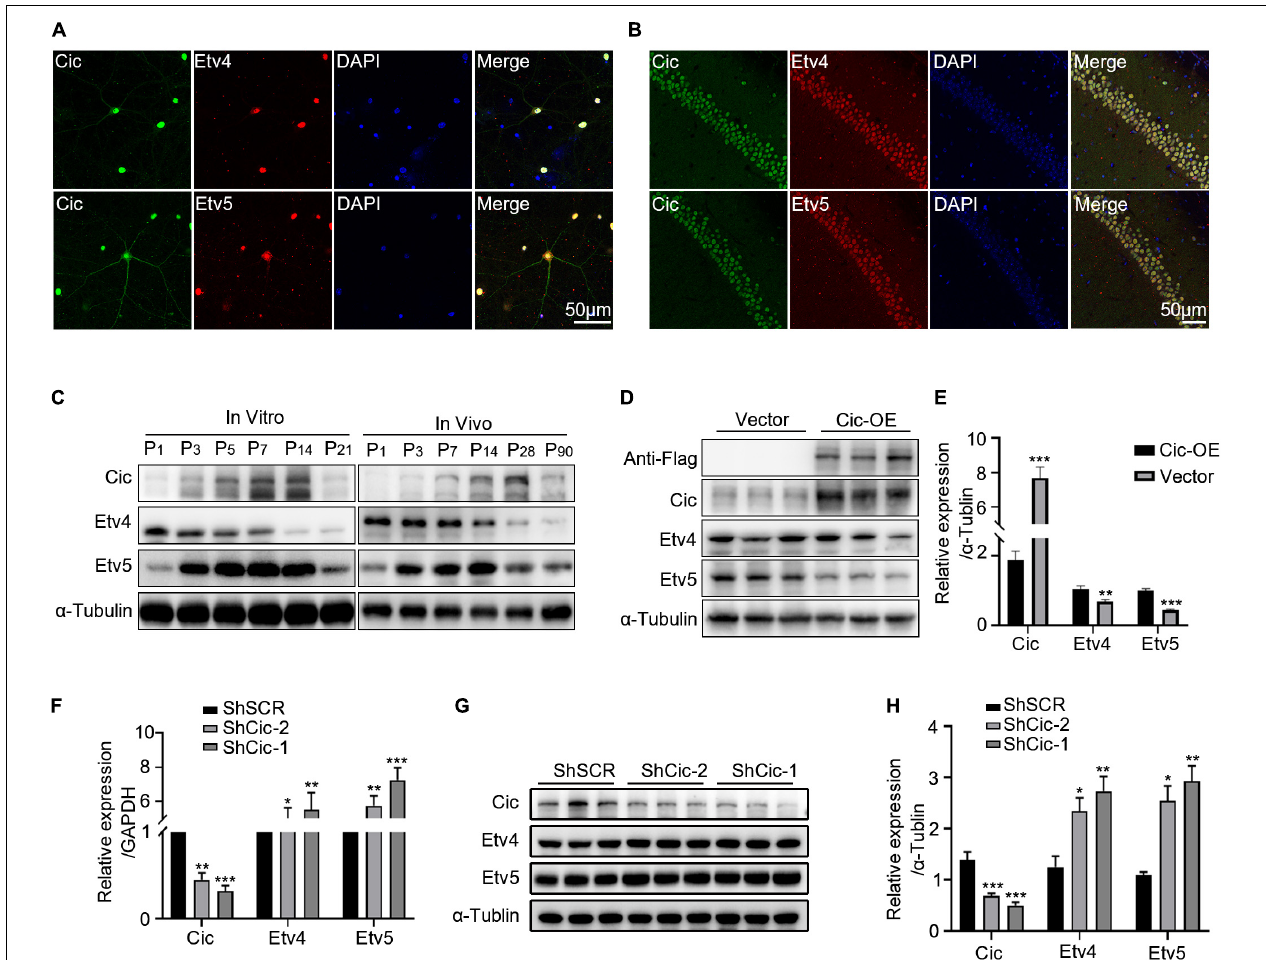
FIGURE 4 | Cic represses Ets factor expression in the dendritic growth of hippocampal neurons. (A) Localization of Cic (green) and Etv4 (top) (red) or Etv5 (bottom) (red) in dissociated mouse hippocampal neurons after DIV13. Nuclear staining with DAPI is also shown. Last panel showed merged images. (B) Localization of Cic (green) and Etv4 (top) (red) or Etv5 (bottom) (red) in coronal sections of the mouse hippocampus. (C) Hippocampal culture lysates from DIV 1 to 21 and mouse hippocampal homogenates obtained at the indicated stages were immunoblotted to detect Cic, Etv4, and Etv5. α -Tubulin was used as a loading control. (D) HT22 cells were infected for 3 days with either lenti-control vector or lenti-Cic-OE, and WB was used to ascertain the change in Cic and Ets following overexpression of Cic in HT22 cells. (E) shows quantification of WB in d. (F–H) Hippocampal neurons cultured in vitro were infected on DIV 7 for 7 days with either lenti-scramble ShSCR or lenti-ShRNA against Cic (ShCic-1, ShCic-2). (F) mRNA levels of Ets were assessed by qPCR following Cic knockdown in hippocampal neurons. (G) The expression of Ets following Cic knockdown in neurons was detected by WB. (H) Quantification of the WB in G. The error bars indicate the SE. *** p < 0.001; ** p < 0.01; * p <